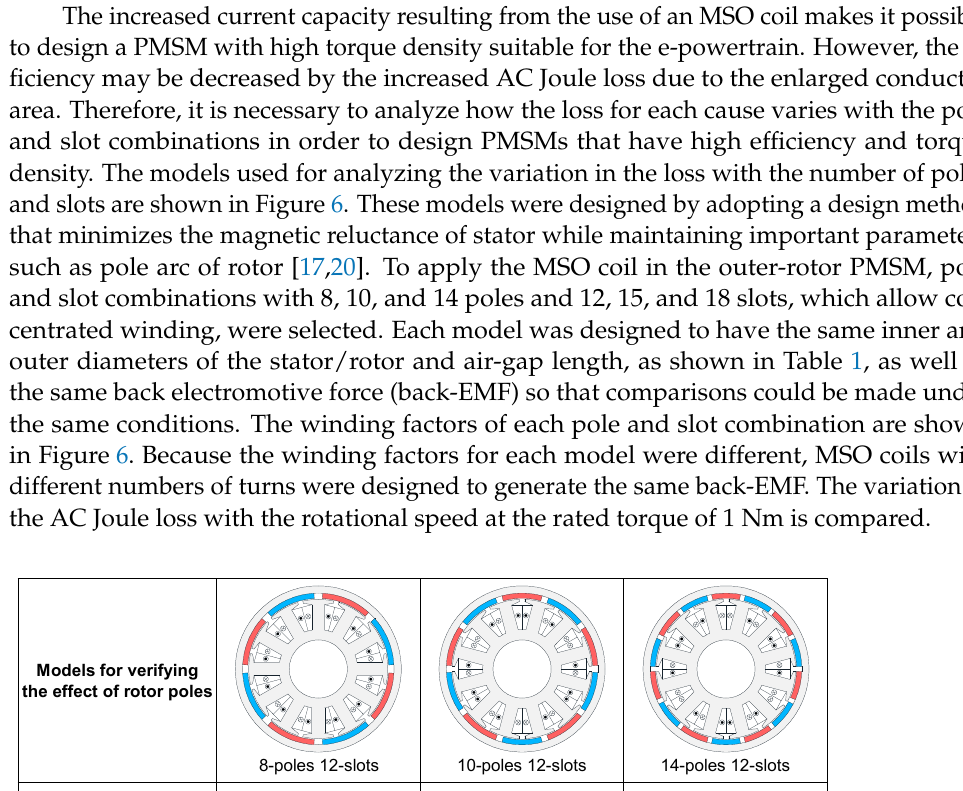
Figure 5. Verification of the proposed method.